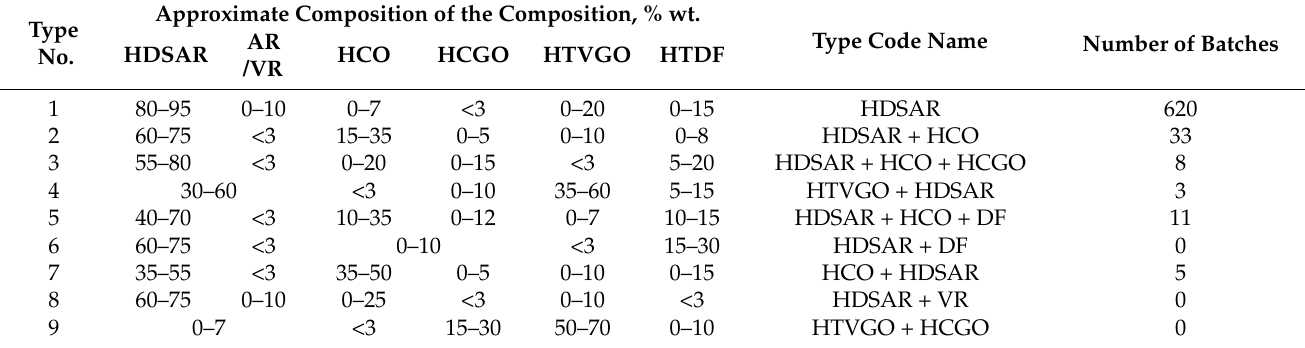
Table 11. Distribution of shipments of ports of the Middle East by type